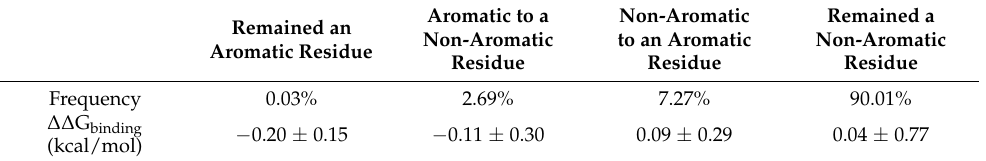
Table 4. ∆∆ G binding average values for four different sets of residues according to aromaticity